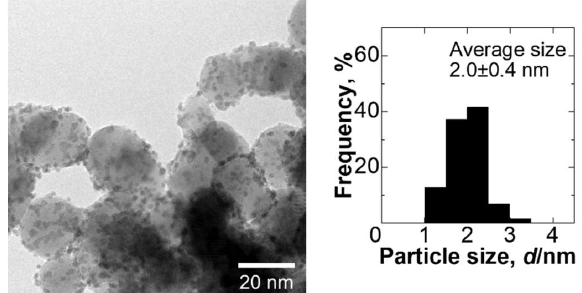
Figure 1. TEM image and particle size distribution histogram for IrO x /Sb-SnO 2 catalyst. The average diameter and size distribution of the loaded IrO x particles were estimated from ca. 300 particles in more than six TEM images.